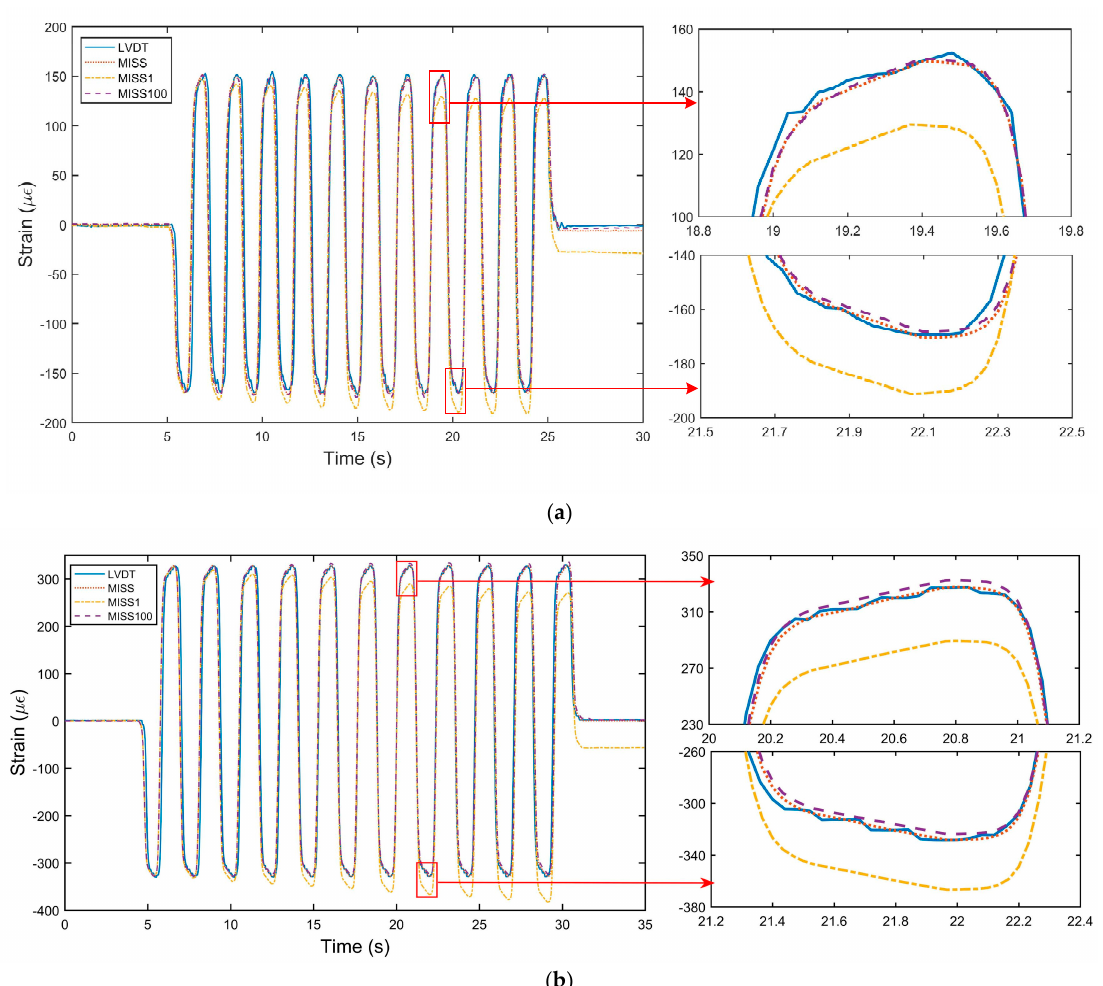
Figure 6. Comparison results of the dynamic tests. ( a ) Results for ±5 μ m sin waves; ( b ) Results for ±10 μ m sin waves.